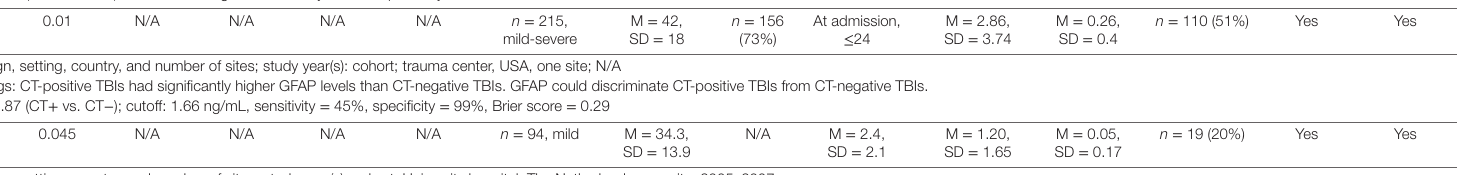
Study design, setting, country, and number of sites; study year(s): cohort; University hospital, The Netherlands, one site; 2005–2007 Main Findings: CT-positive TBIs had significantly higher GFAP levels than CT-negative